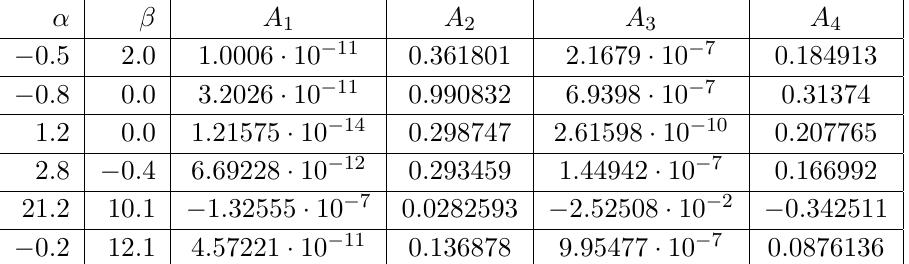
Table 1. The coe(cid:14)cients of the (cid:12)t function in (B.8) for di(cid:11)erent values of (cid:11) and (cid:12) with (cid:12)xed m 2 = (cid:0) 0 : 4. Whenever the Ricci curvature becomes very negative the coe(cid:14)cient A 1 and A 3 di(cid:11)er more signi(cid:12)cantly from the expected zero value and thus our numerical results are less